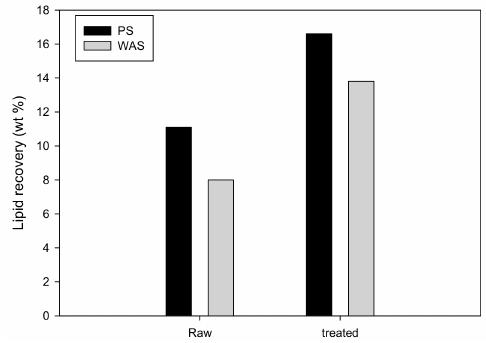
Figure 5. Improvement of the lipid recovery e ffi ciency of sludges though hydrothermal